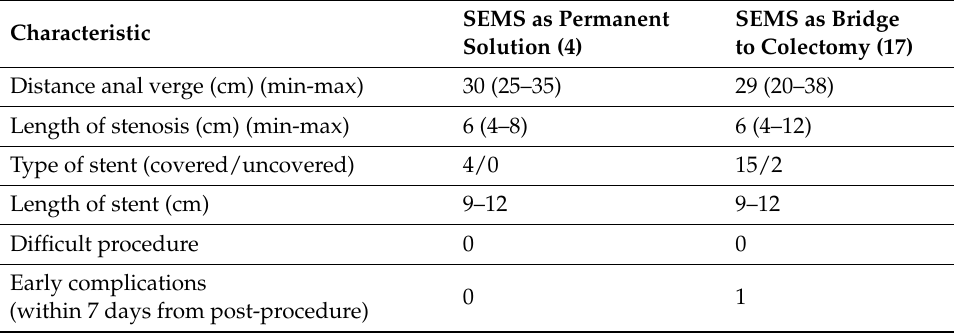
Table 2. Pathology of the colonic obstruction in 21